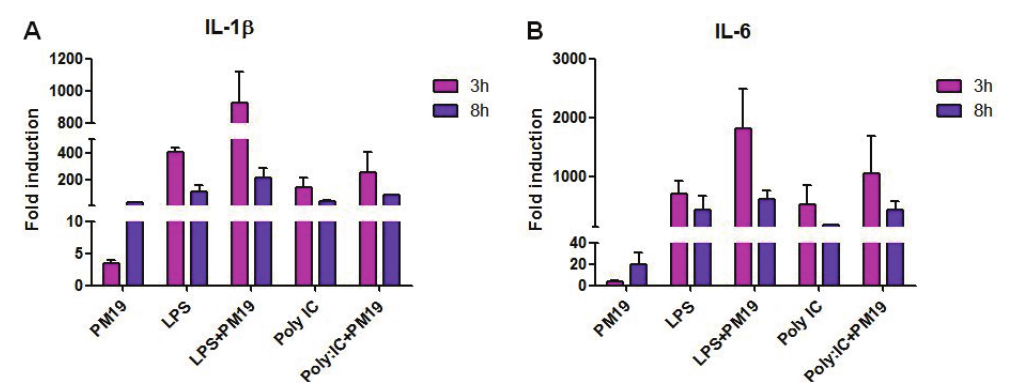
Figure 5. Expression of proinflammatory cytokines IL-1 β ( A ), IL-6 ( B ), TNF α ( C ), and IFN γ ( D ) was assessed by Real Time PCR. Experiments were conducted on iMDDCs from 3 healthy donors. Data are shown as fold induction and represent the mean ±